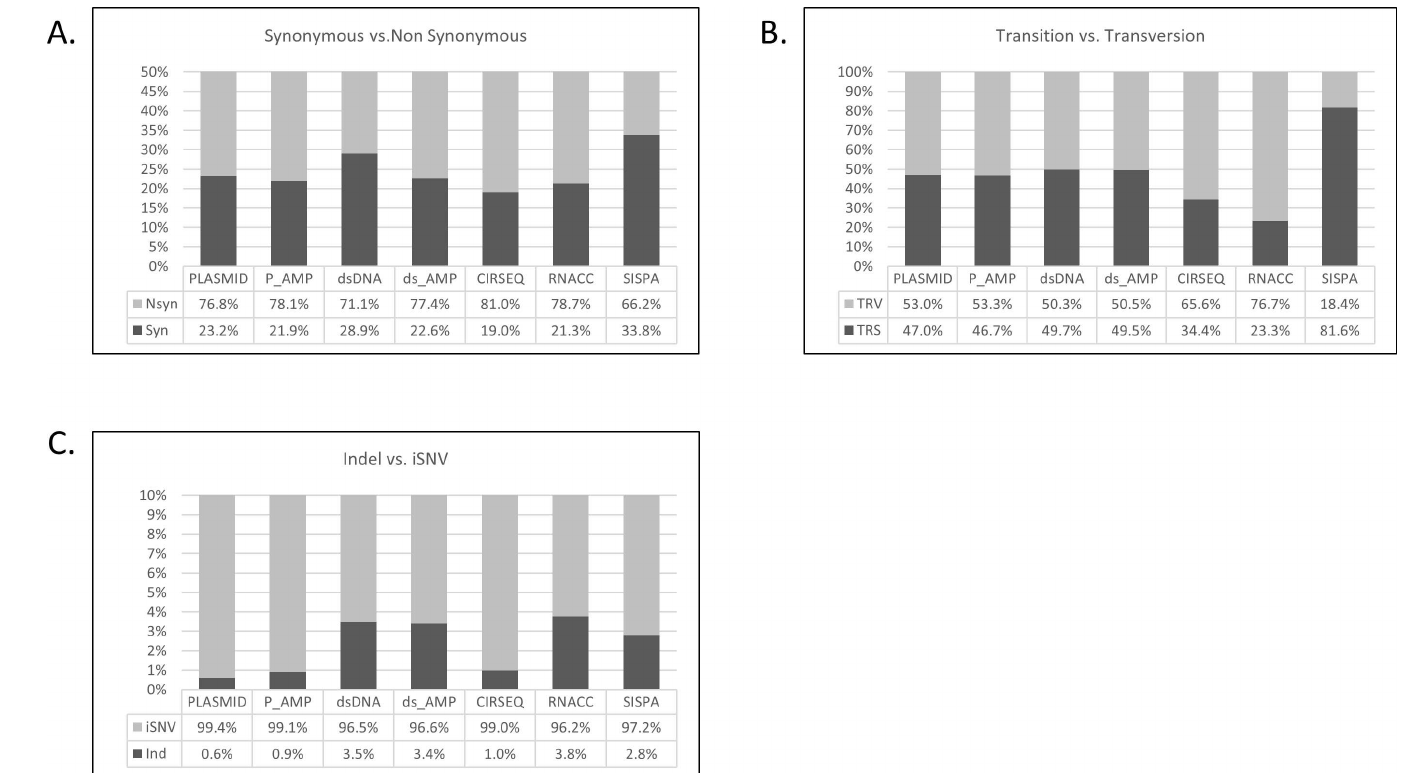
Fig 3. Percentage of errors by type of acquired diversity determined during sample preparation. (A) Percentageof error attributed to synonymousvs. non-synonymous variants. (B) Percentage of errors attributed to transitions vs. transversions. (C) Percentageof errors attributed to insertionsor deletions vs. Intra-host single nucleotide variants